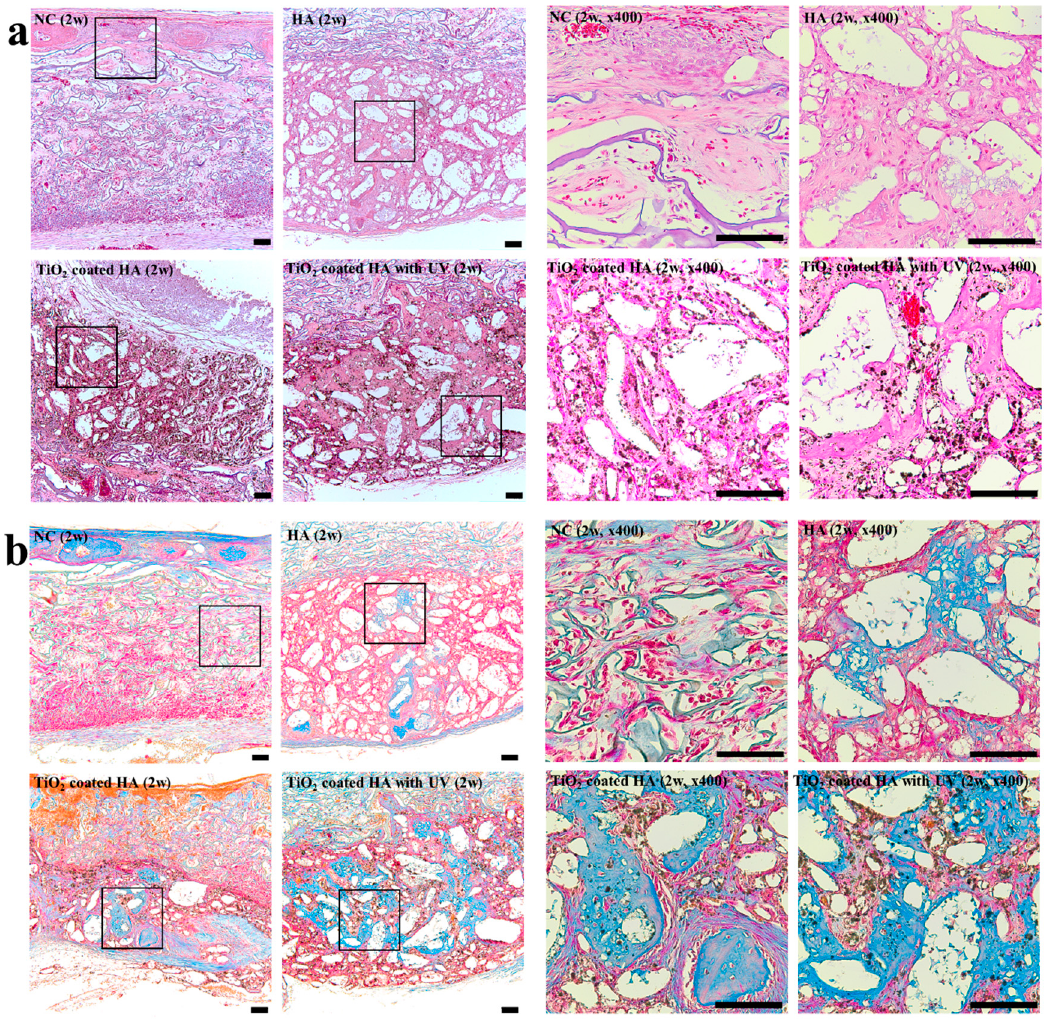
Figure 2. Histological findings (2 weeks). ( a ) Left : Light microscopy using hematoxylin and eosin (H&E) stain ( × 100) showing new bone formation in the groups at two weeks postoperatively; NC group, HA group, TiO 2 -coated HA group, and TiO 2 -coated HA with UV group. In UV-treated group (lower-left), there was significantly more newly formed bone than in the other groups. Right : Magnification of ( a ) ( × 400). Scale bar: 100 um; ( b ) Left : Light microscopy using Masson trichrome stain ( × 100) showing new bone formation in the groups at two weeks postoperatively; NC group, HA group, TiO 2 -coated HA group, and TiO 2 -coated HA with UV group. In the UV-treated group (lower-left), the residual graft materials were surrounded by blue-colored woven bone. Right : Magnification of ( b ) ( × 400). Scale bar: 100 um.